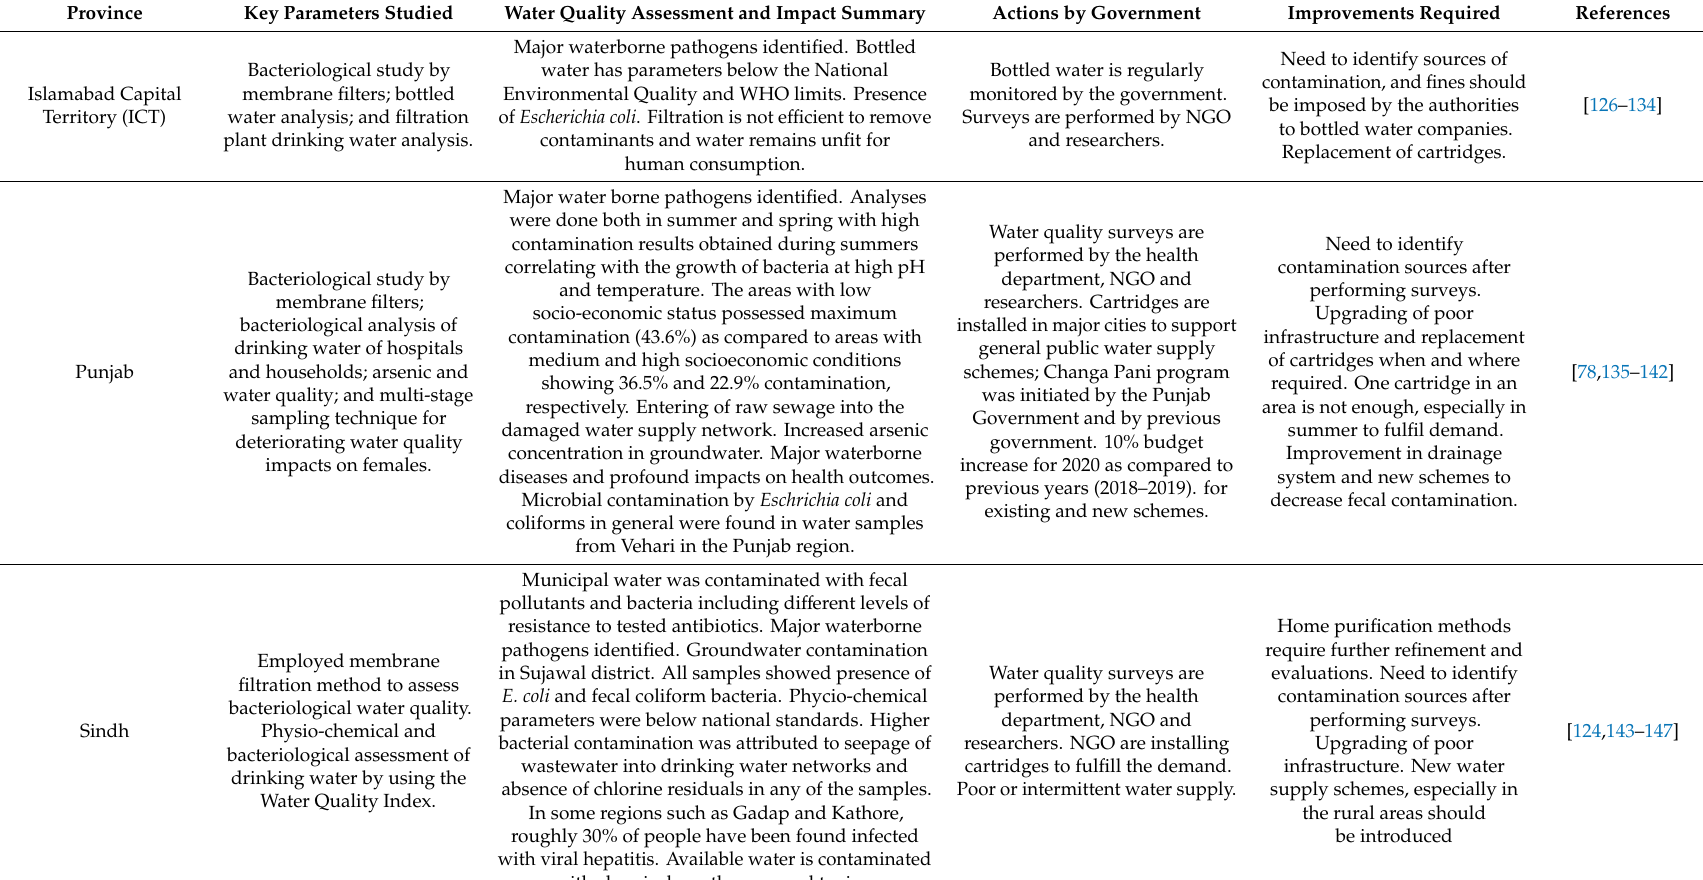
Table 4. Water quality situation in di ff erent provinces of Pakistan and associated impacts on the parameters